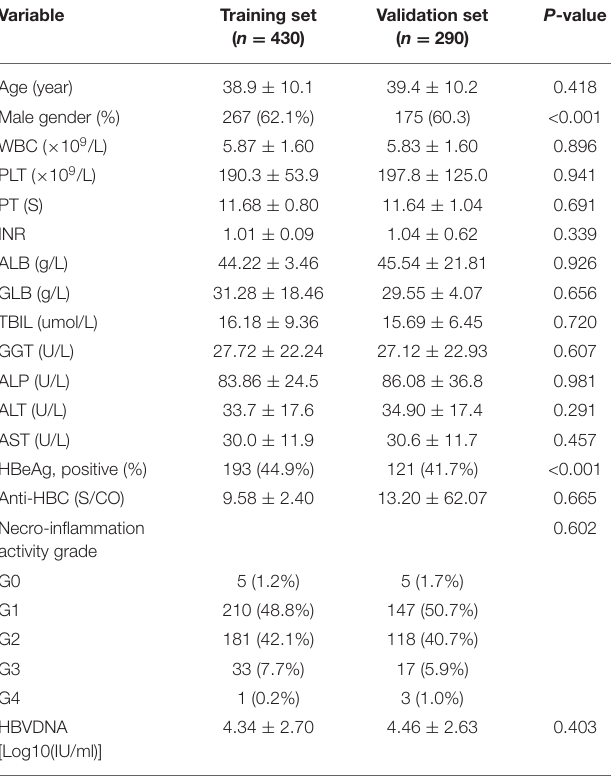
TABLE 3 | Multivariate logistic regression analysis of independent predictors with significant liver inflammation in the training